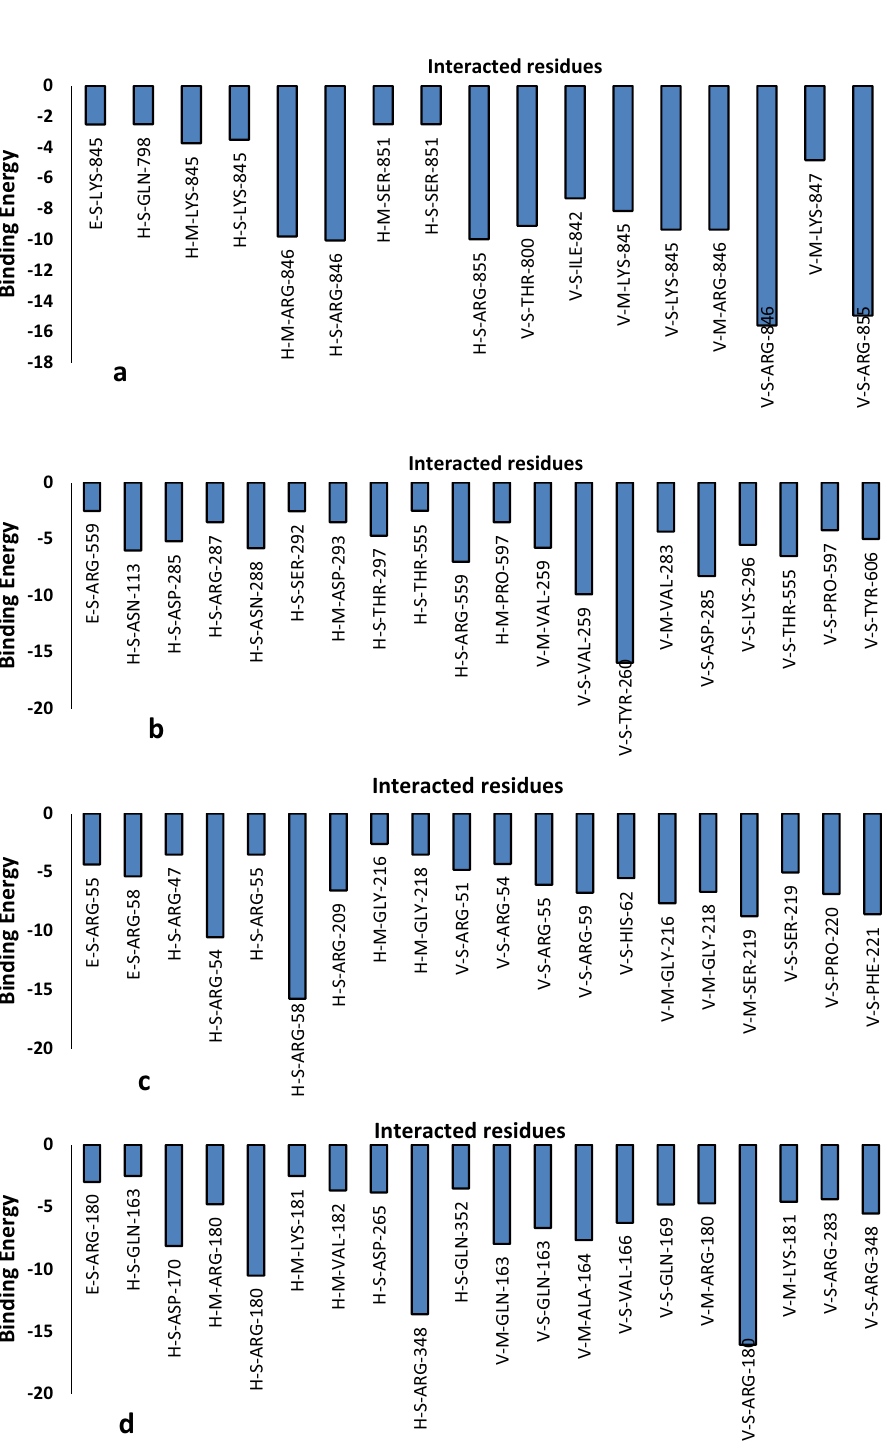
Antibacterial activity of mulberry pectin. Antibacterial activity of mulberry pectin was assessed by the resazurin assay method utilizing microtitre-plate 28 . Micro titer plate method (96 wells) to check the minimum inhibition concentration (MIC). The Pectin sample (BR-2 and S-13) were assessed for their MIC against 6 bacterial strains namely, Bacillus cereus, Staphylococcus aureus, Streptococcus mutans, E-coli, Pseudomonas aeruginosa, and Salmonella typhi . Sample preparation: 10 mg of the sample was dissolved in 1 mL Dimethyl sulfoxide (DMSO) and 100 µL of dissolved samples were used to check the Minimum Inhibition Concentration (MIC) for respective